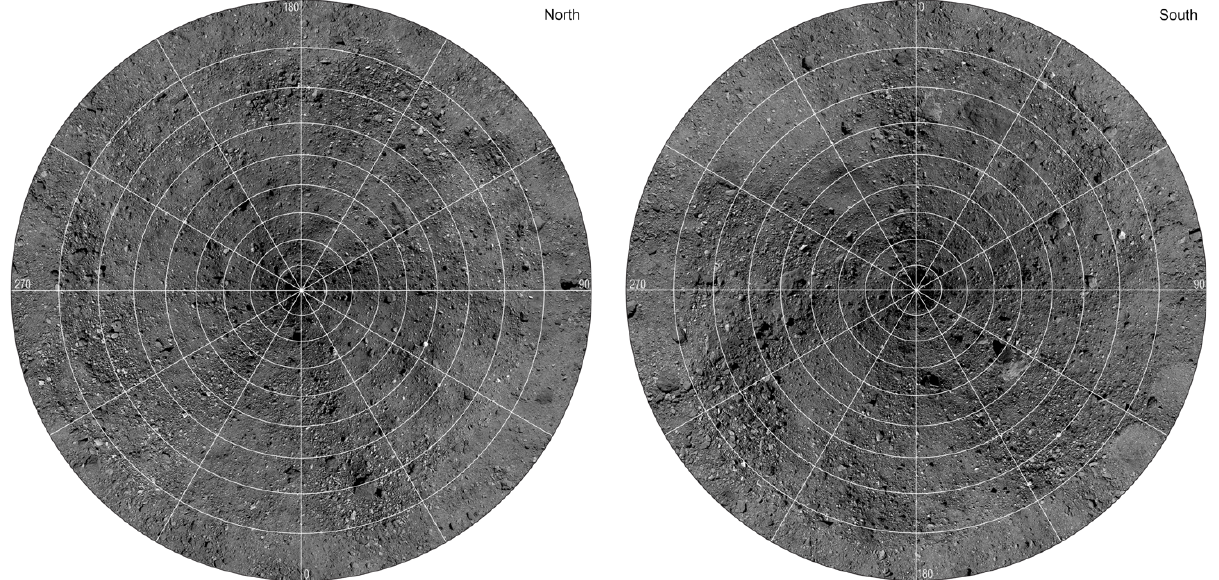
Figure 6. Global basemap north and south views in polar stereographic projection (Bennett et al., 2020). Latitude ranges from 0° to 90°N (left) and 0° to 90°S (right). Latitude grid is in 10° increments, starting from 0° at the outermost mark.